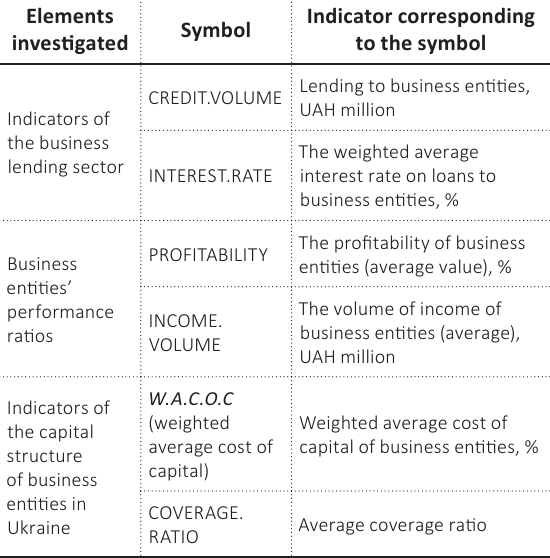
Table 1. Factors (indicators) for analysis Elements Symbol investigated